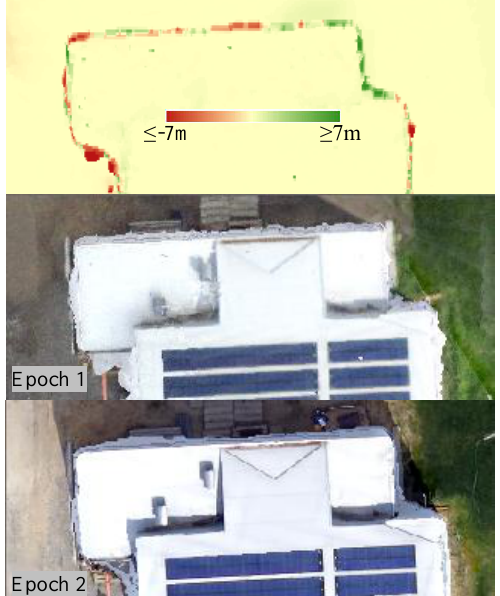
Figure 7: Sudden height changes in between epochs for stable objects